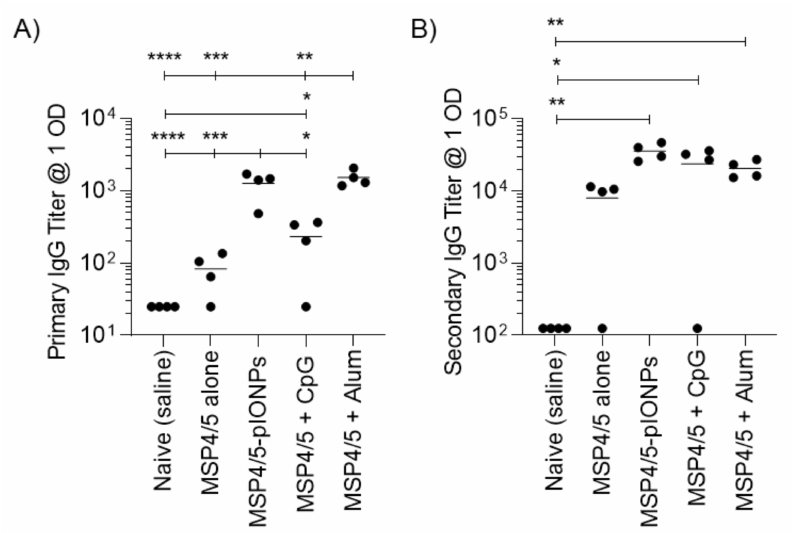
Figure 6. Antibody responses to pIONPs- MSP4 / 5 compared with the TLR9 agonist, CpG 1826 and Alum. Total IgG responses two weeks after one ( A ) and two ( B ) immunizations (4 weeks total) with MSP4 / 5 protein (50 µ g / per mouse) alone, conjugated to pIONPs (0.57% solids per mouse), mixed with CpG (25 ug per mouse) or mixed with Alum (0.3% final). Titers were calculated by fitting the titration curve with a four-parameter logistic model and interpolating to the selected cut-o ff , OD = 1. Where the curves did not reach this cut-o ff , the titer was set at half the lowest dilution. Data presented as individual mice ( n = 4 / group) with mean titer. All stats were completed using a one-way ANOVA with Tukey’s multiple comparison test. ELISA stats were completed on log transformed data to standardize variances. * p < 0.05, ** p < 0.01, *** p < 0.001, **** p <